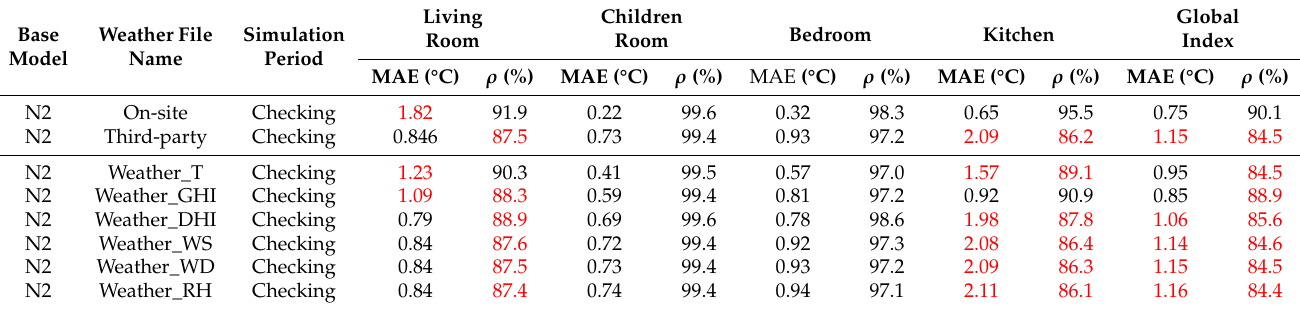
Table A2. MAE and ρ indices per thermal zone in the checking period. House N2, base